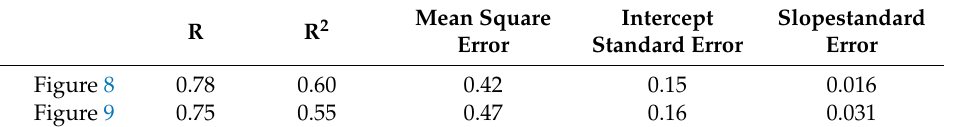
Figure 9. Suspended sediment concentration (SSC) as a function of the shear stress calculated by Figure 8 Equation (3) from 13 – 17 December 2014 (linear fit of the tot al stress Pearson’s r is 0.75). Figure 9